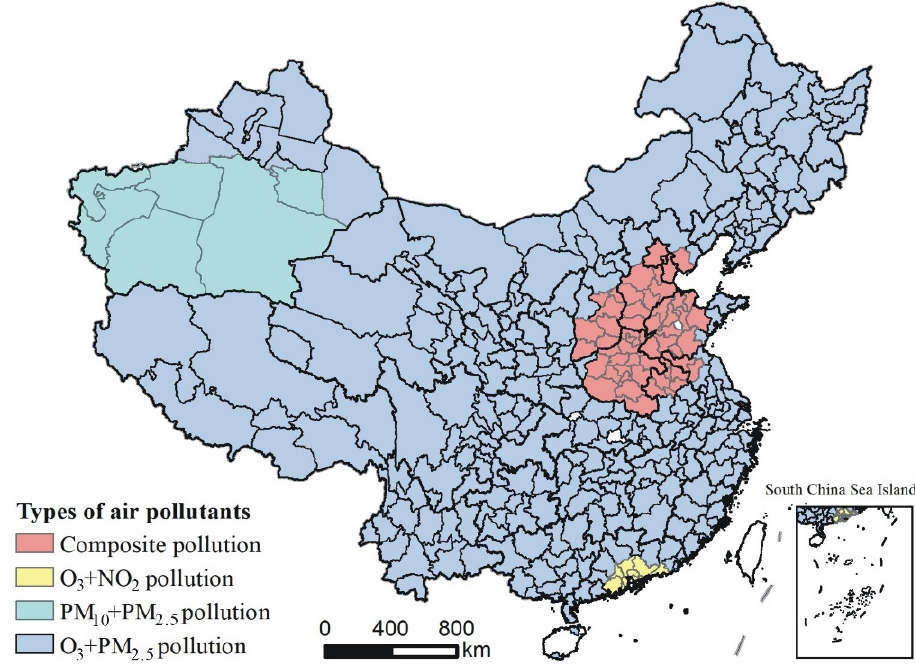
Figure 4. Types of regions of the major pollutants during the CAP period.